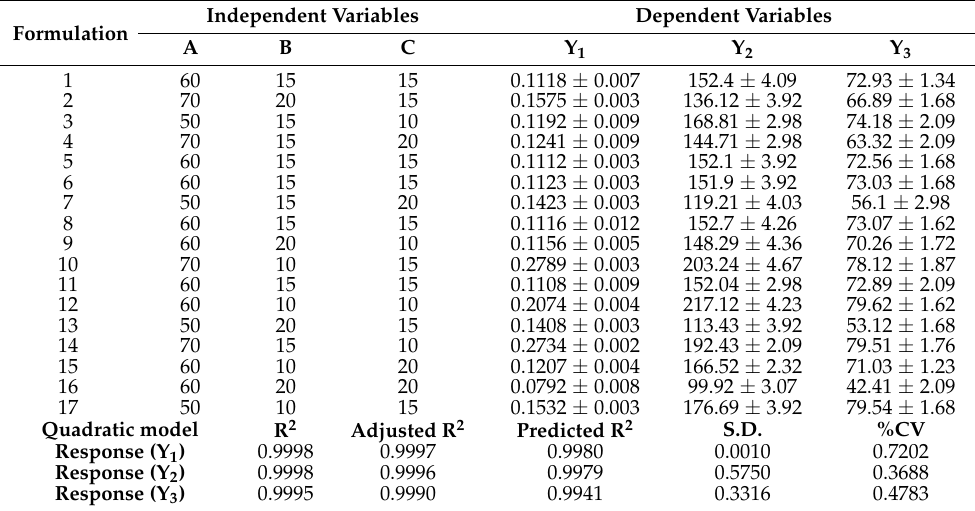
Table 2. Box–Behnken experimental design with measured